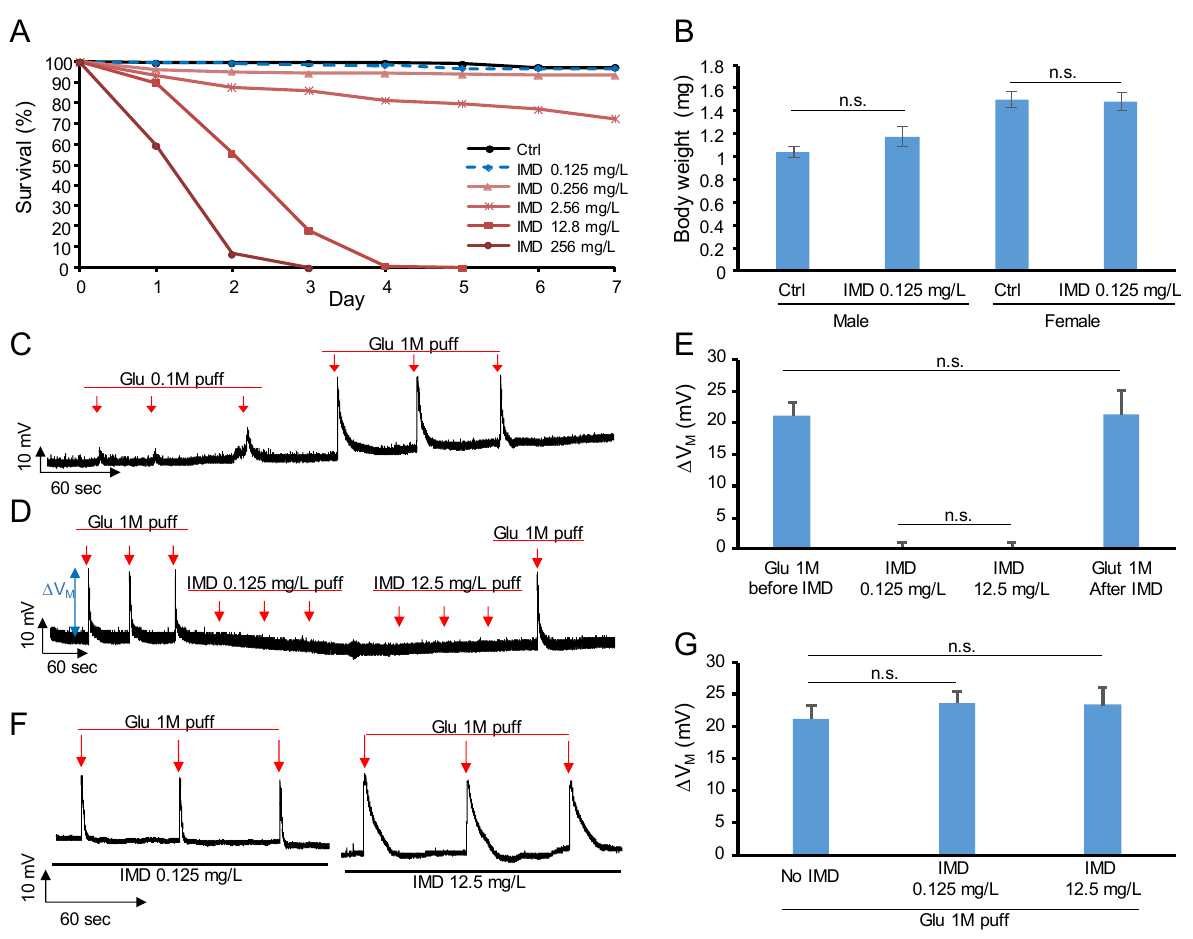
Figure 1. The selection of the dose of IMD and the acute application on the glutamatergic neuromuscular junction (NMJ) of the fruit fly: ( A ) survival of fruit flies receiving different doses of IMD; ( B ) the dose of 0.125 mg/L did not affect the body weight of the flies; ( C ) the representative voltage recording showing the puff of glutamate on NMJ triggered a dose-dependent synaptic voltage change; ( D ) the representative voltage recording showing two doses of IMD puff did not trigger voltage change of NMJ nor decrease the amplitude of the following glutamate puff; ( E ) the quantification of ( D ); ( F ) the representative voltage recording showing two doses of IMD did not antagonize glutamate puff; ( G ) the quantification of ( F ). The error bar stands for the standard error of the mean. The red arrows stand for the puff of chemicals on NMJ. ∆ V M , voltage change of the membrane potential; IMD, imidacloprid; Glu, glutamate. n.s., not significant.